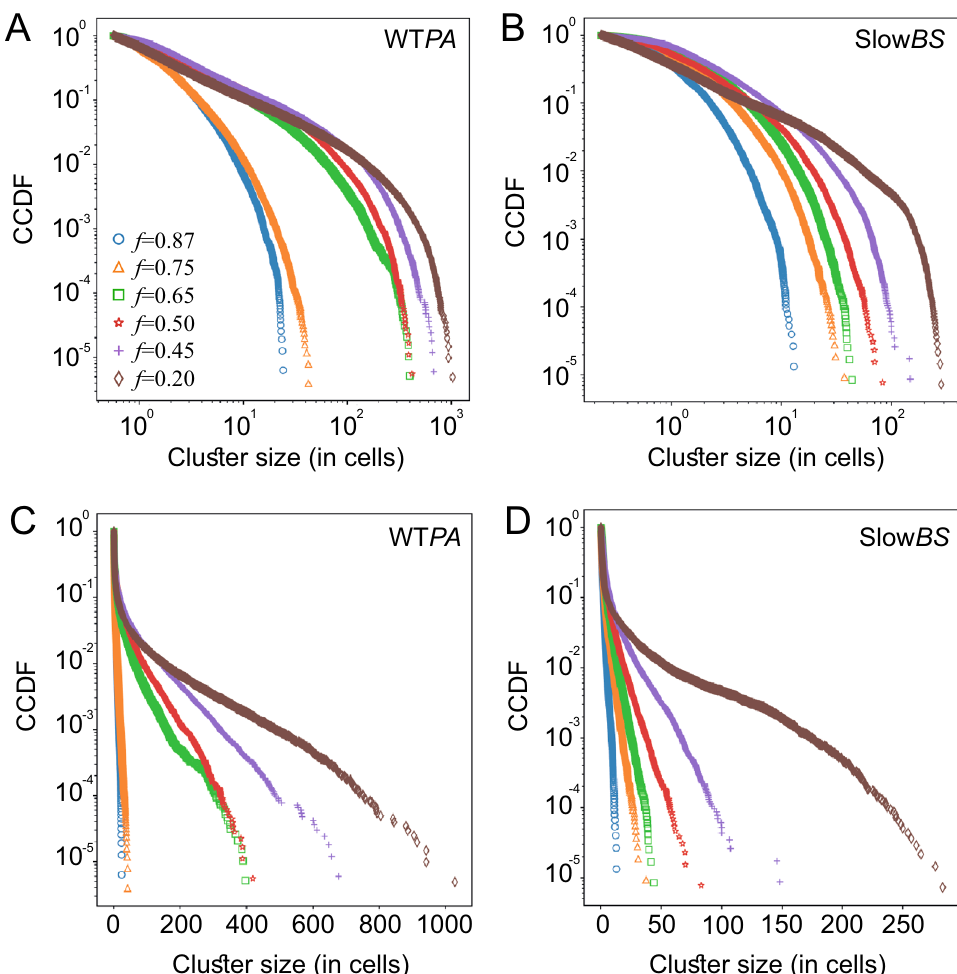
Figure 3. Cluster size distribution. The Complementary Cumulative Distribution Function (CCDF) of same-species cell-clusters sizes. ( A , C ) WT P. aeruginosa (mixed with WT B. subtilis ) and ( B , D ) slow B. subtilis (mixed with WT B. subtilis ). Top: log–log plots, compare with the bottom, showing semi-log plots. Curves show different density ratios, f , at a fixed area fraction ρ = 0.25. As expected, the characteristic cluster size decreases with f . With f = 0.2, the cluster size-distribution of slow B. subtilis becomes significantly wider, resembling a power-law across two order of magnitudes with an exponential